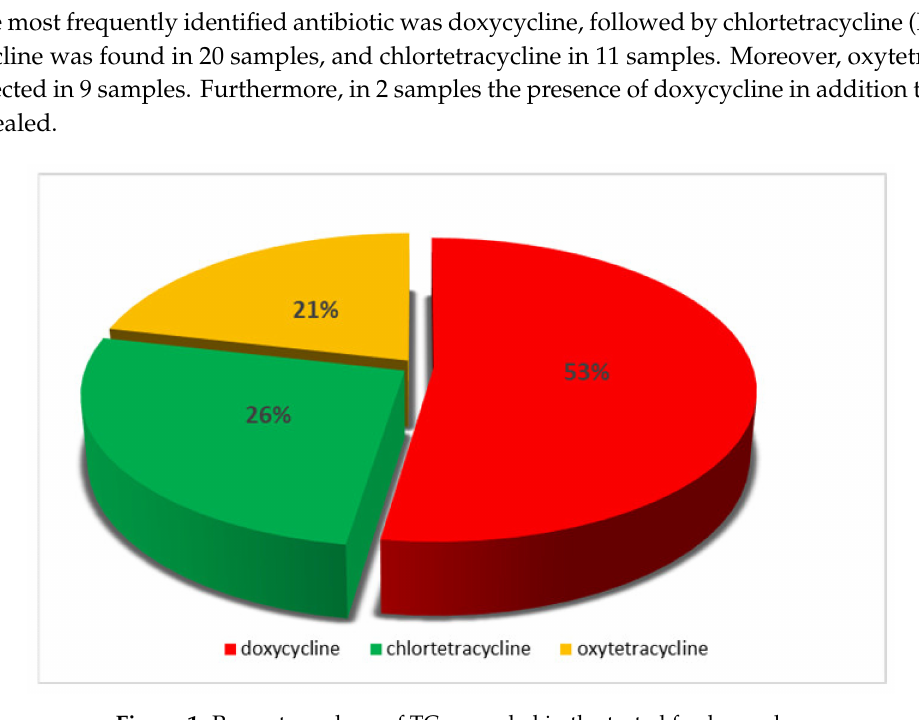
Figure 1. Percentage share of TCs revealed in the tested feed samples.